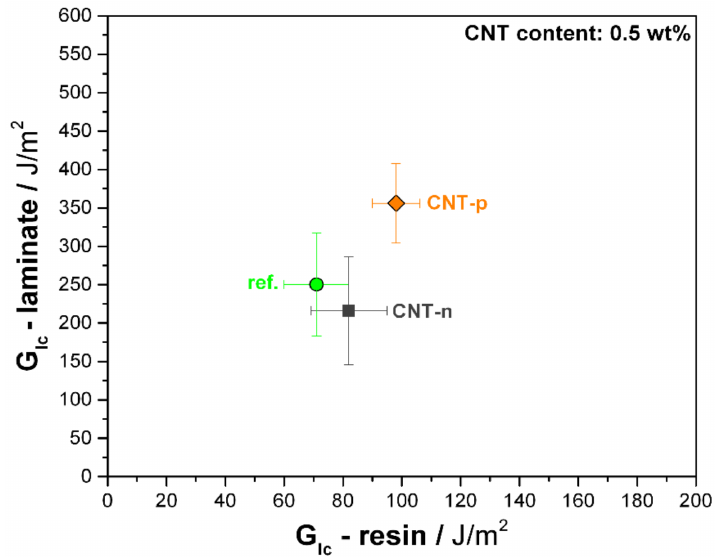
Figure 8. G Ic of neat and 0.5 wt.% MWCNT-modified epoxy resin and UD prepreg